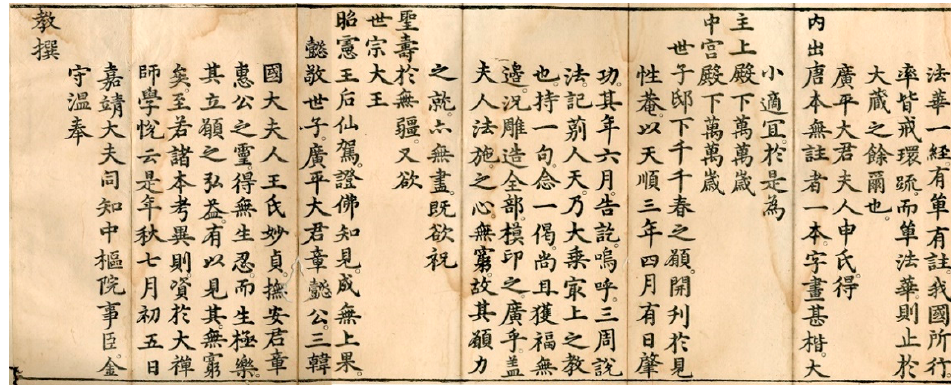
Figure 7. Lotus Sutra , published at Gyeonseongam Hermitage, Vol. 7 Postscript (Dongguk University Museum 2014, p. 25).